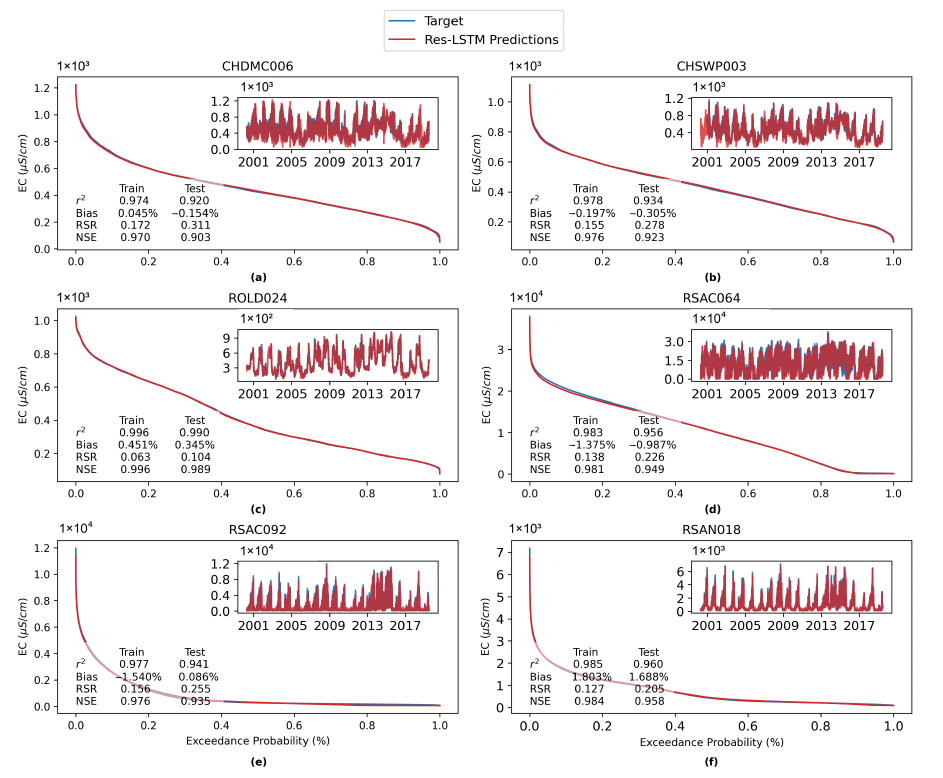
Figure 11. Exceedance probability plot and time series plot of Res-LSTM simulated versus observed salinity at daily time step with daily inputs.